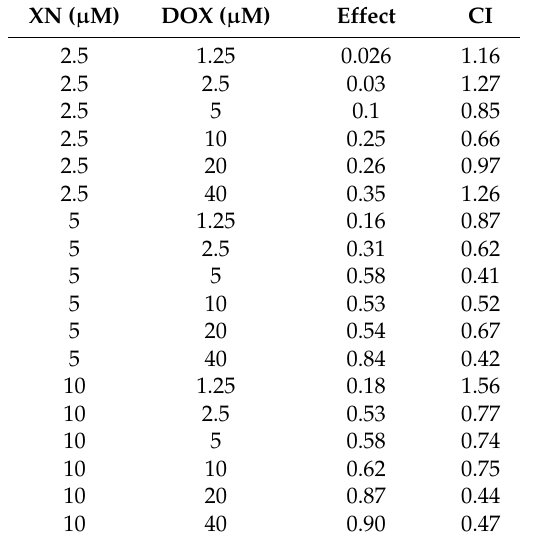
Table 1. Result of isobolographic analysis showing CI of DOX in the presence of different concentrations of XN in MCF-7/ADR cells. The CI values were calculated by CompuSyn (ComboSyn, Inc., Paramus, NJ, USA).